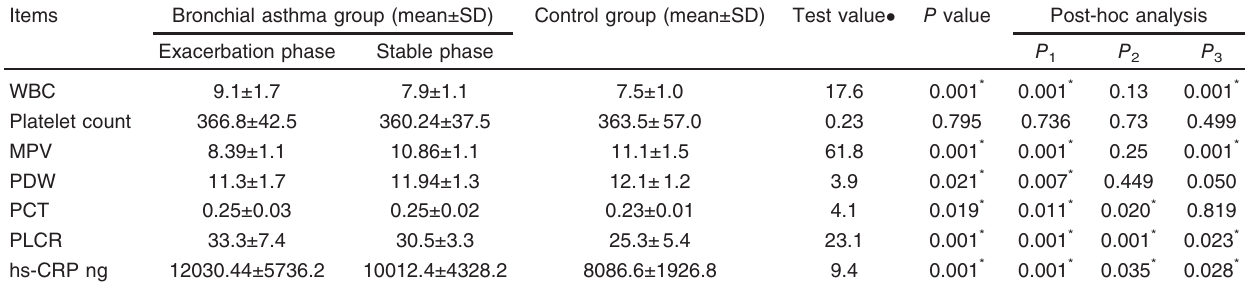
Table 2 Comparison of platelet count, platelet indices, white blood cells, and high-sensitivity C-reactive protein during exacerbation phase, stable phase, and control